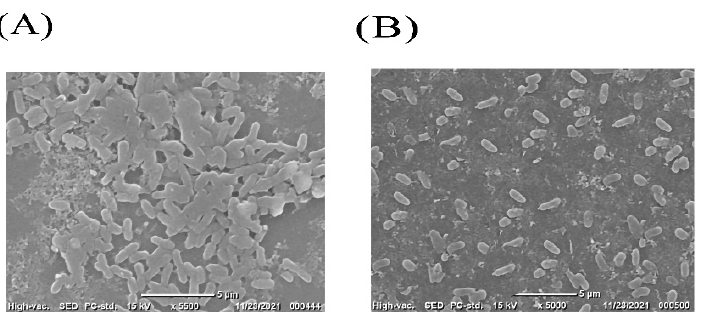
Figure 2. Representative scanning electron micrographs showing biofilm disruption on glass surfaces ( A ) Biofilm formed by Pseudomonas sp. ( B ) biofilm disruption by co-incubation with 100 µ L of CFS from Bacillus subtilis and bacterial culture of Pseudomonas sp.